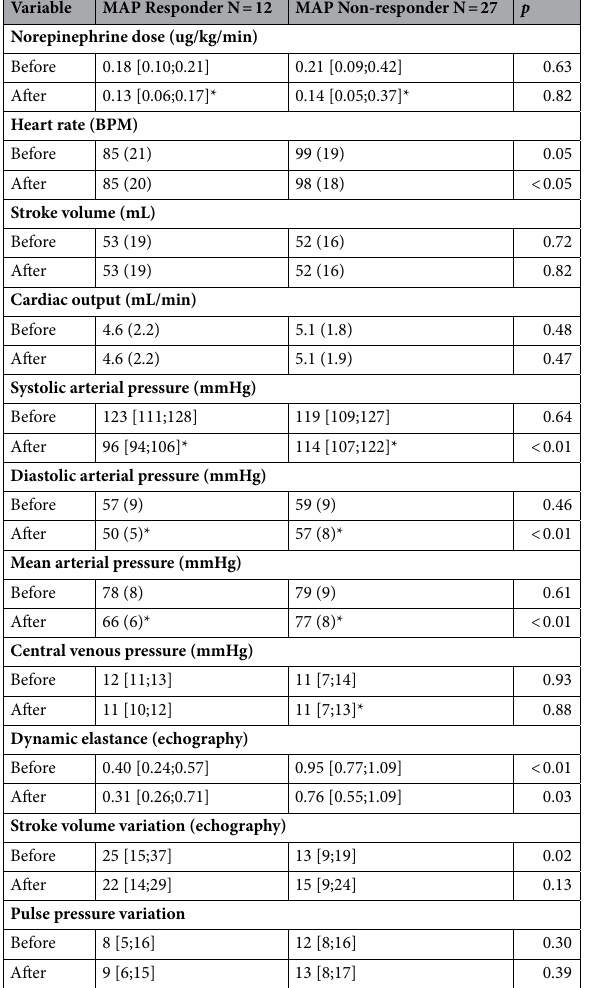
Table 2. Hemodynamic variable before and after decreasing norepinephrine dose. p value refer to between group comparison, * represent significant differences for within group (before-after) comparison. MAP: mean arterial